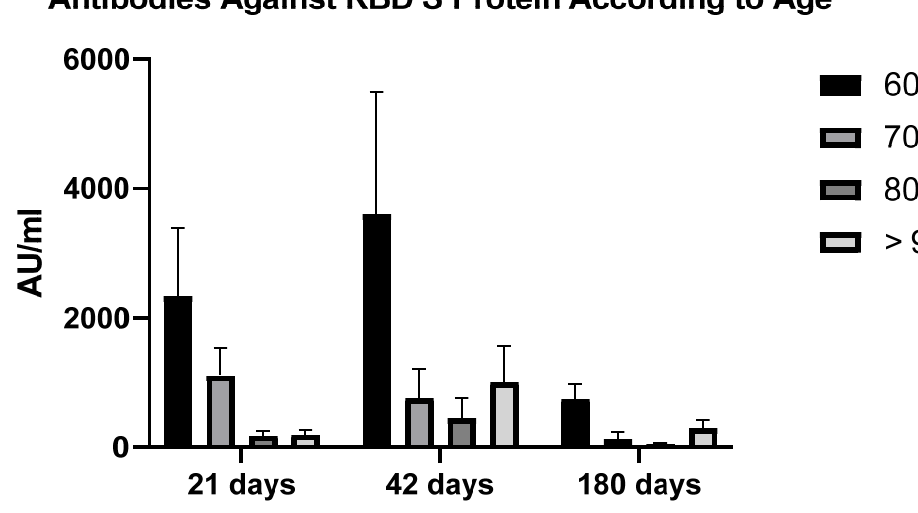
Figure 3. Antibody levels obtained at 21-, 42- and 180-days post-vaccination, following stratification into 4 different groups according to their age (P = NS (Group 60–69 versus 70–79, 80–89, >90 years old at all time periods analyzed) (ANOVA)).